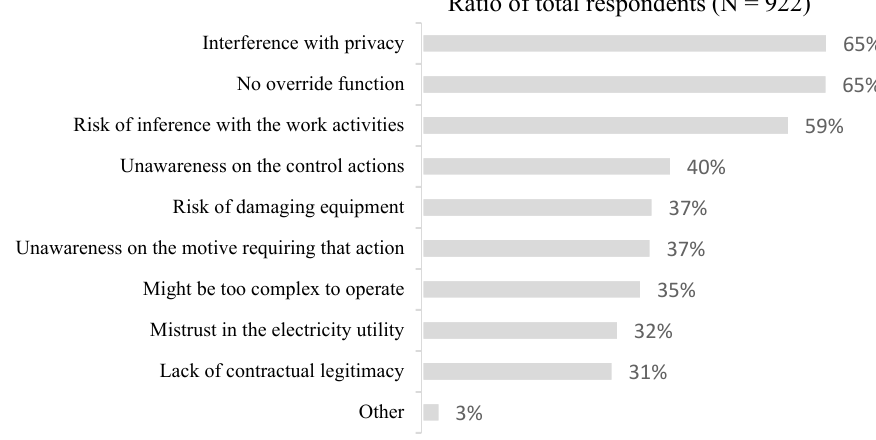
Figure 9. Reasons to not follow the recommendations from the electricity utility and manually control the appliances.